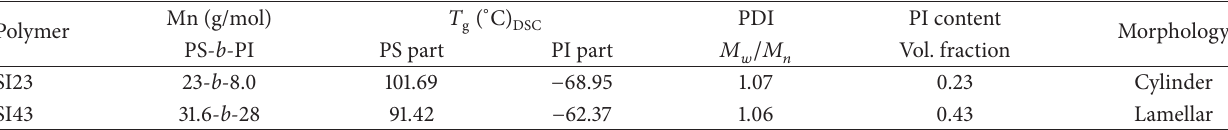
Table 1: Characterization data of PS-b-PI copolymers. Volume fractions of polyisoprene were calculated from specific volumes of PS and PI [25,